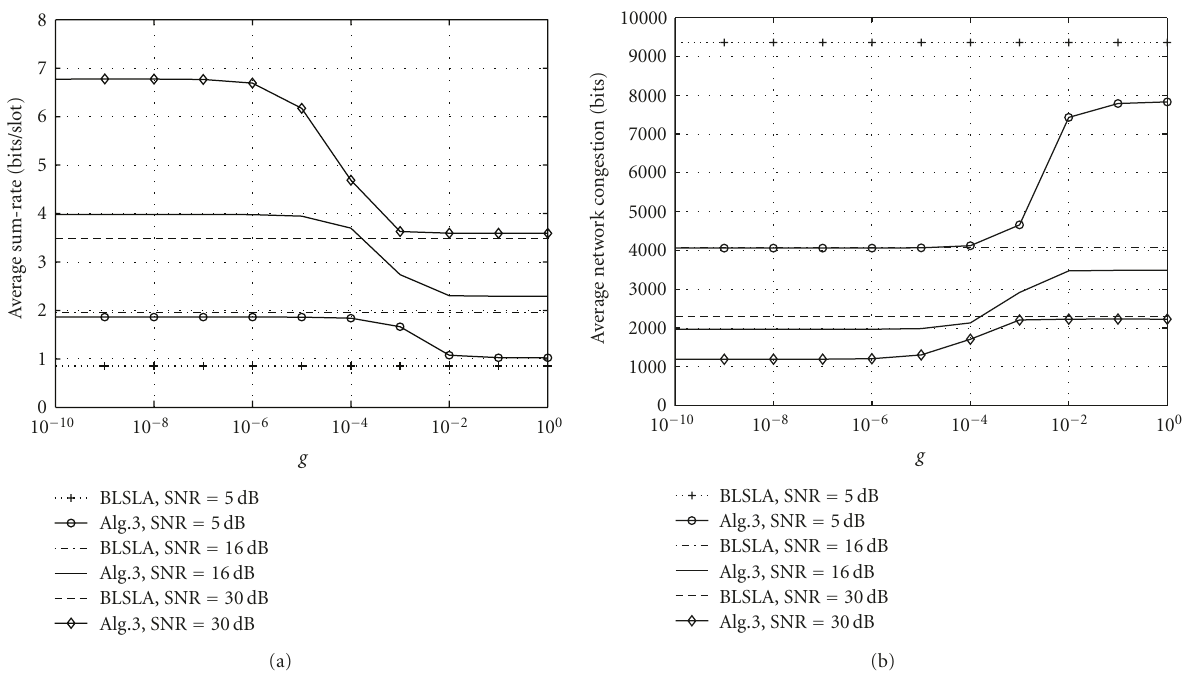
(cid:2) (cid:2) 4 2 (b) on the self-interference q s n = 1 s = 1 n